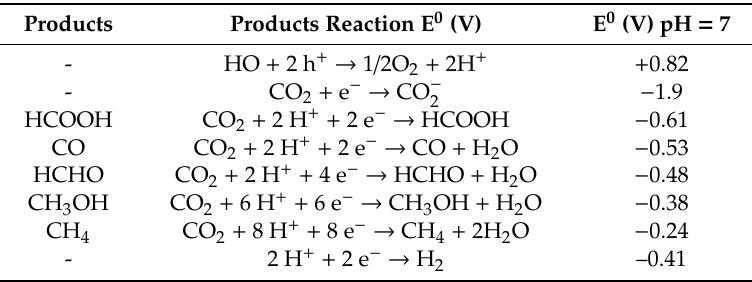
Table 1. Redox potentials for CO 2